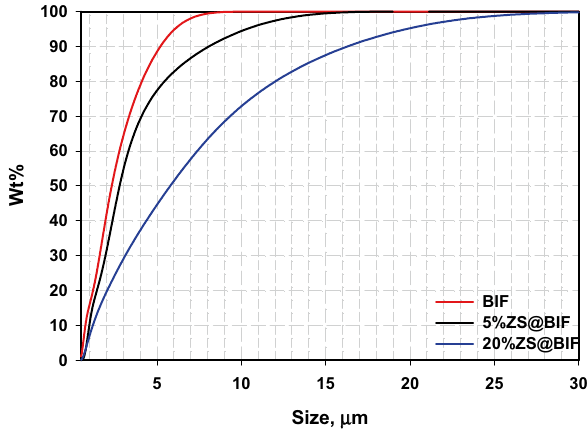
Figure 5. Particle size analysis of BIF, 5% ZS@BIF, and 20% ZS@BIF sample.